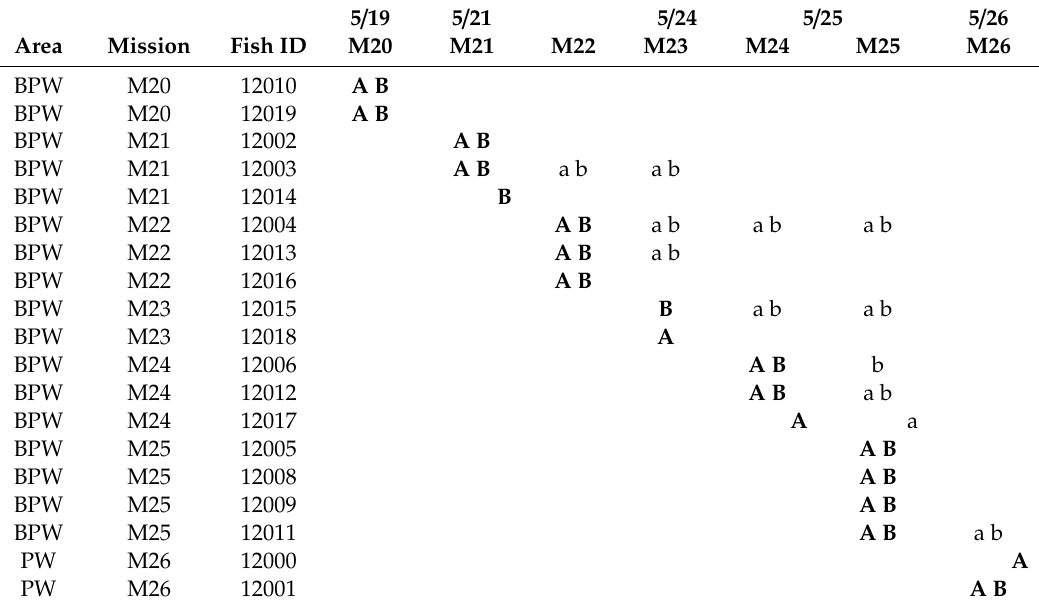
M21 12002 A B BPW M21